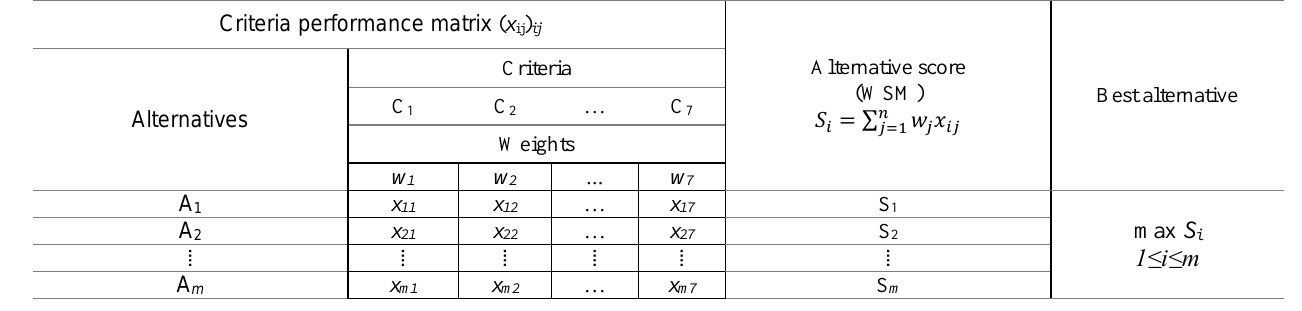
Table 2. Criteria performance matrix and best